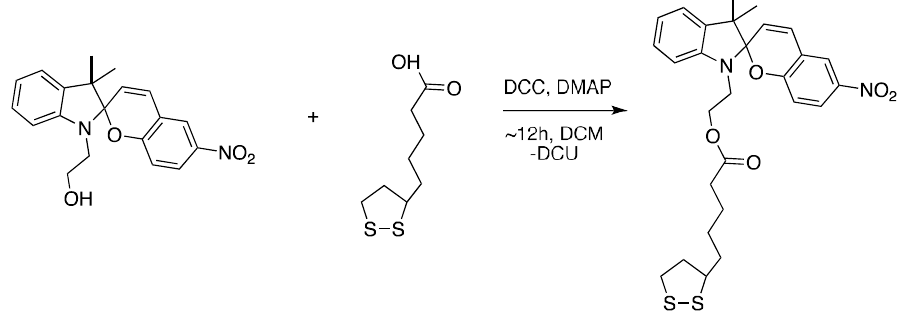
Figure 1. Synthesis of 2-( 3′ , 3′ -dimethyl-6-nitrospiro[chromene-2, 2′ -indolin]- 1′ yl) -5-(1,2-dithiolan-3- yl)pentanoate from 2-( 3′ , 3′ -dimethyl-6-nitrospiro[chromene-2, 2′ -indolin]- 1′ -yl) ethanol and L-thioctic acid in the presence of N ’ -dicyclohexylcarbodiimide (DCC) and 4- N, N -dimethylaminopyridine (DMAP).